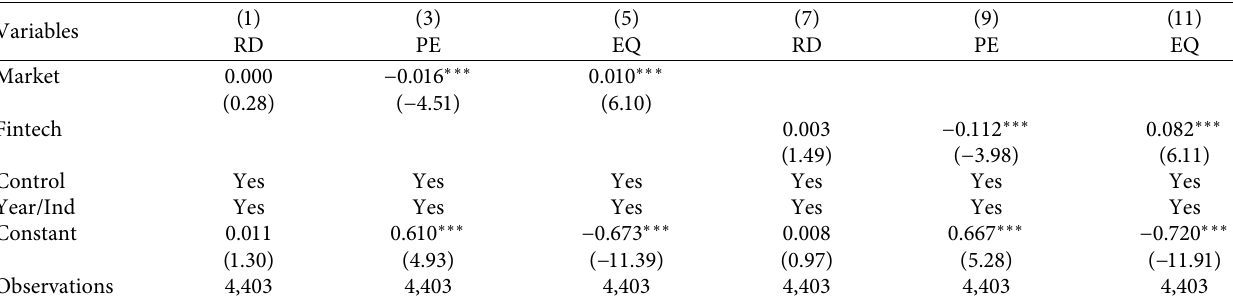
Table 12: Regression results for state-owned enterprises.